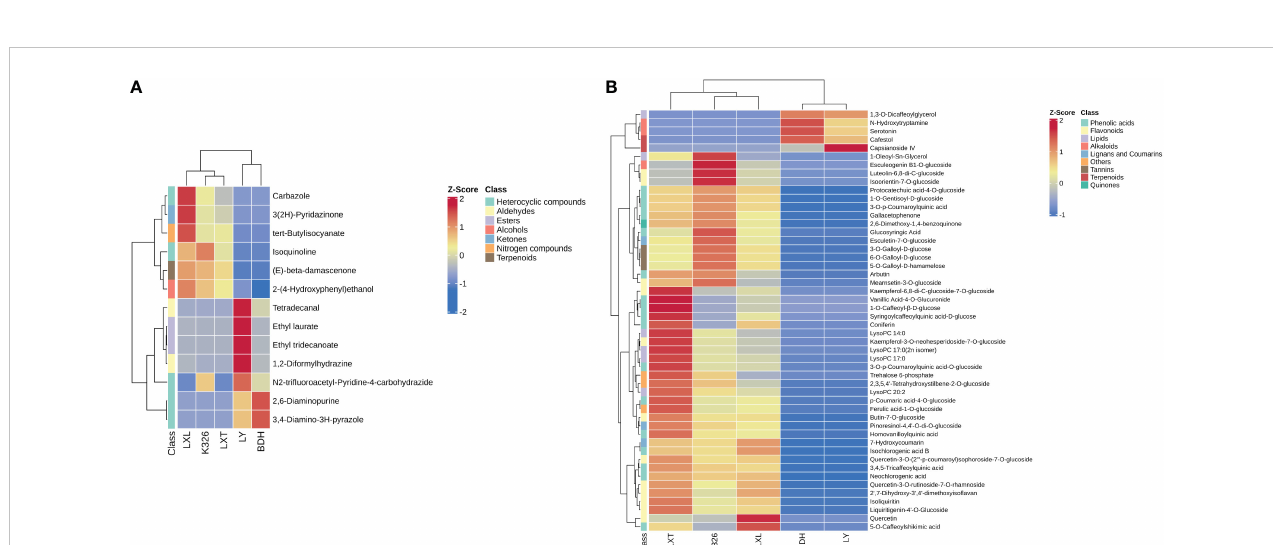
FIGURE 4 Analysis of metabolite variation among fi ve tobacco varieties within chemical classes. (A) Heatmap of 13 volatile metabolites including one alcohol, two aldehydes, two esters, fi ve heterocyclic compounds, one ketone, one nitrogen compound and one terpenoid. (B) Heatmap of the top 50 discriminating non-volatile compounds ranked by t-test including three alkaloids, 12 fl avonoids, three lignans and coumarins, six lipids, 17 phenolic acids, three tannins, two terpenoids, one quinone, one saccharide and two other non-volatile metabolites. Volatile and non-volatile metabolite data were normalized within each variety via z-transformation. The resulting z-scores were converted into colors and grouped using hierarchical clustering. The color in each cell represents the z-transformed abundances of the averaged replicates (n = 3) per tobacco variety (red: high, blue: